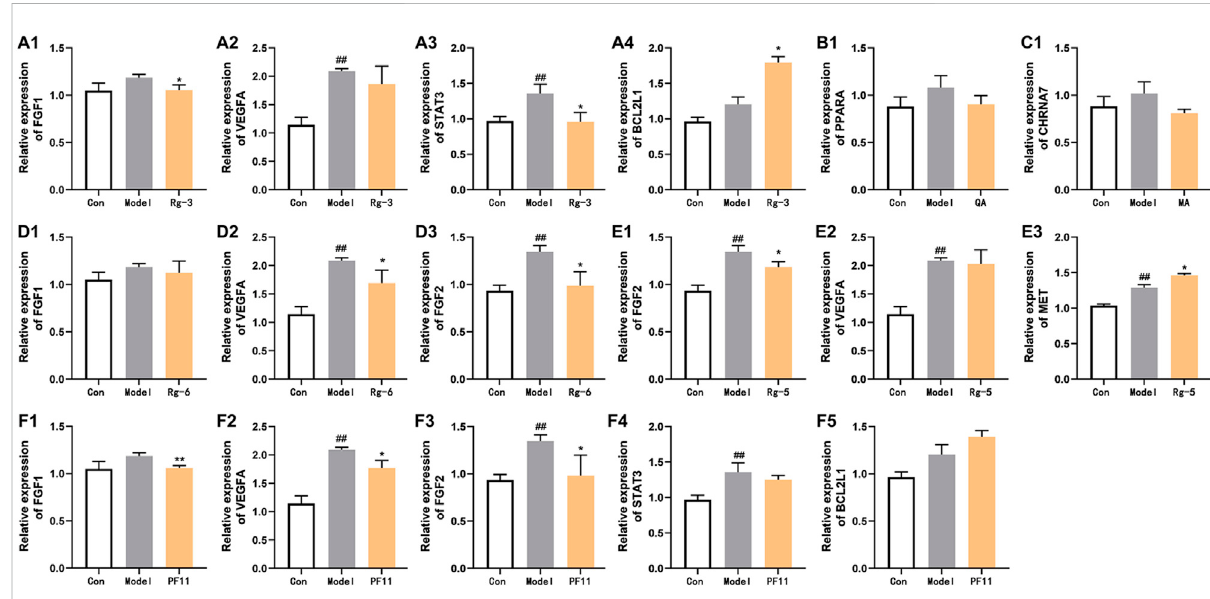
FIGURE 6 Effects of potential active compounds on heart failure-related gene expression. (A – F) Results of gene expression in zebra fi sh treated with ginsenoside Rg3, quinic acid, malic acid, ginsenoside Rg6, ginsenoside Rg5, and pseudoginsenoside F11, ## p < 0.01 vs. the control group, * p < 0.05 and ** p < 0.01 vs. the model